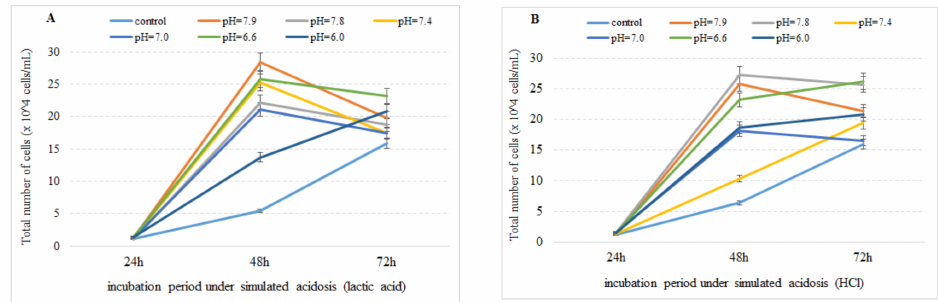
Figure 2. Colon cancer cell viability after seeding in a pH-corrected cell medium adjusted by lactic acid ( A ) and hydrochloric acid ( B ).